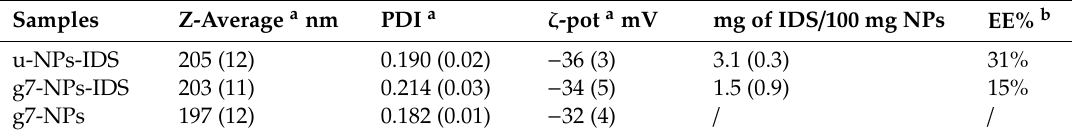
Table 1. Physico-chemical characterization of PLGA nanoparticles. PDI = poly dispersity index; ζ -pot = zeta potential indicating surface charge; EE = encapsulation efficiency. a = values are given as mean ± SD ( n = 9); b = the percentage of encapsulation efficiency was determined as the ratio of the encapsulated out of the total (encapsulated + free) drug percent (%). u-NPs-IDS = untargeted nanoparticles loaded with IDS enzyme; g7-NPs-IDS = brain-targeted nanoparticles loaded with IDS enzyme; g7-NPs = unloaded targeted NPs. Values are intended as mean ± SD ( n = 9).